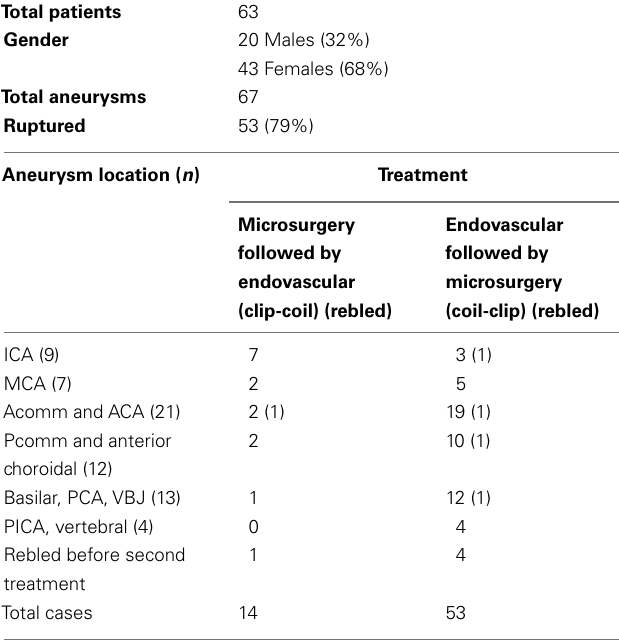
Table 2 | Stanford neurosurgery experience with combined endovascular and microsurgical management of complex aneurysms